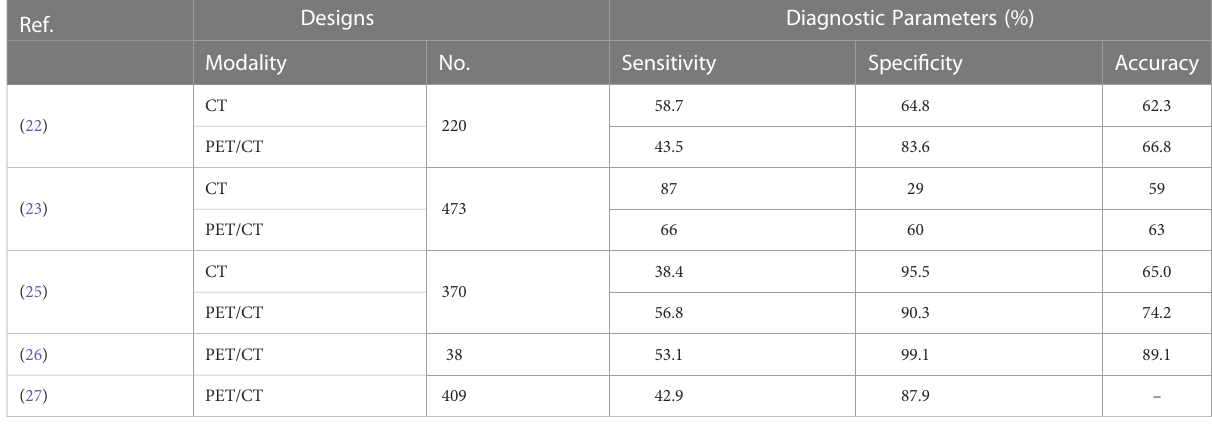
TABLE 1 The comparison of diagnostic performance between CT and PET/CT for N-staging in CRC.